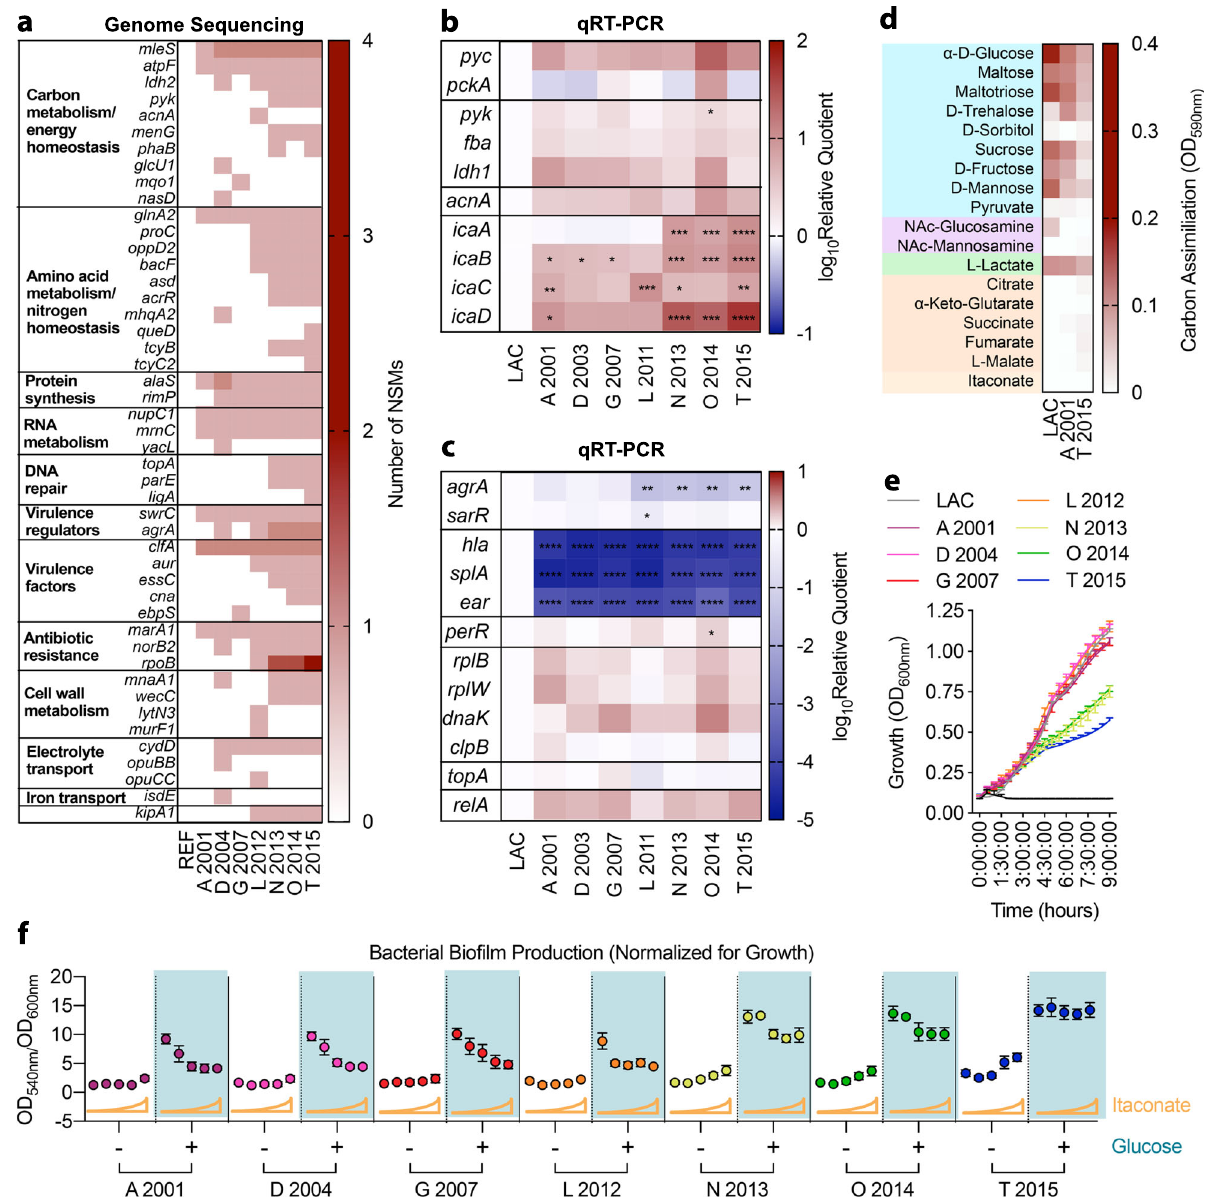
Fig. 5 Clinical isolates exhibit adaptive metabolic changes to itaconate. a Non-synonymous mutations (NSMs) in the genomes of clinical isolates. REF represents a reference isolate from the same patient. b Expression of central carbohydrate metabolic genes and c stress response genes by the clinical isolates, with respect to LAC. d Utilization of carbon sources that feed glycolysis (blue), EPS synthesis (purple), fermentation (green), or the TCA cycle (orange) by the earliest (A 2001) and latest (T 2015) clinical isolates. e Growth of clinical isolates in LB. f Bio fi lm production (normalized for growth) of the clinical isolates in increasing itaconate (0 to 62 mM), with or without glucose (0.5%). Data shown as mean ± SEM from n = 3 biological replicates from 3 independent experiments ( b , c , d , e , f ). Signi fi cance determined by One-Way ANOVA with Tukey ’ s Multiple Comparisons ( b , c ); * P < 0.05, ** P < 0.01, *** P < 0.001, **** P <